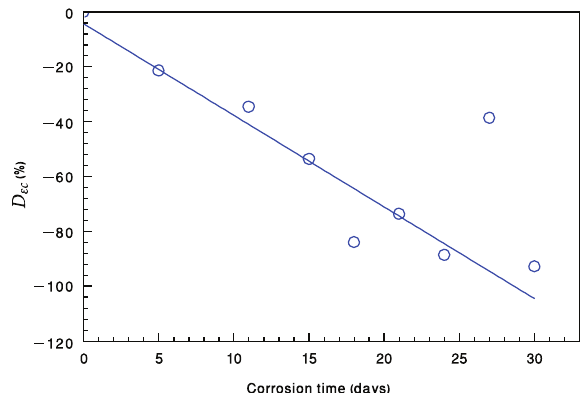
Figure 11: Relation between deterioration ratio of peak stain and corrosion duration.